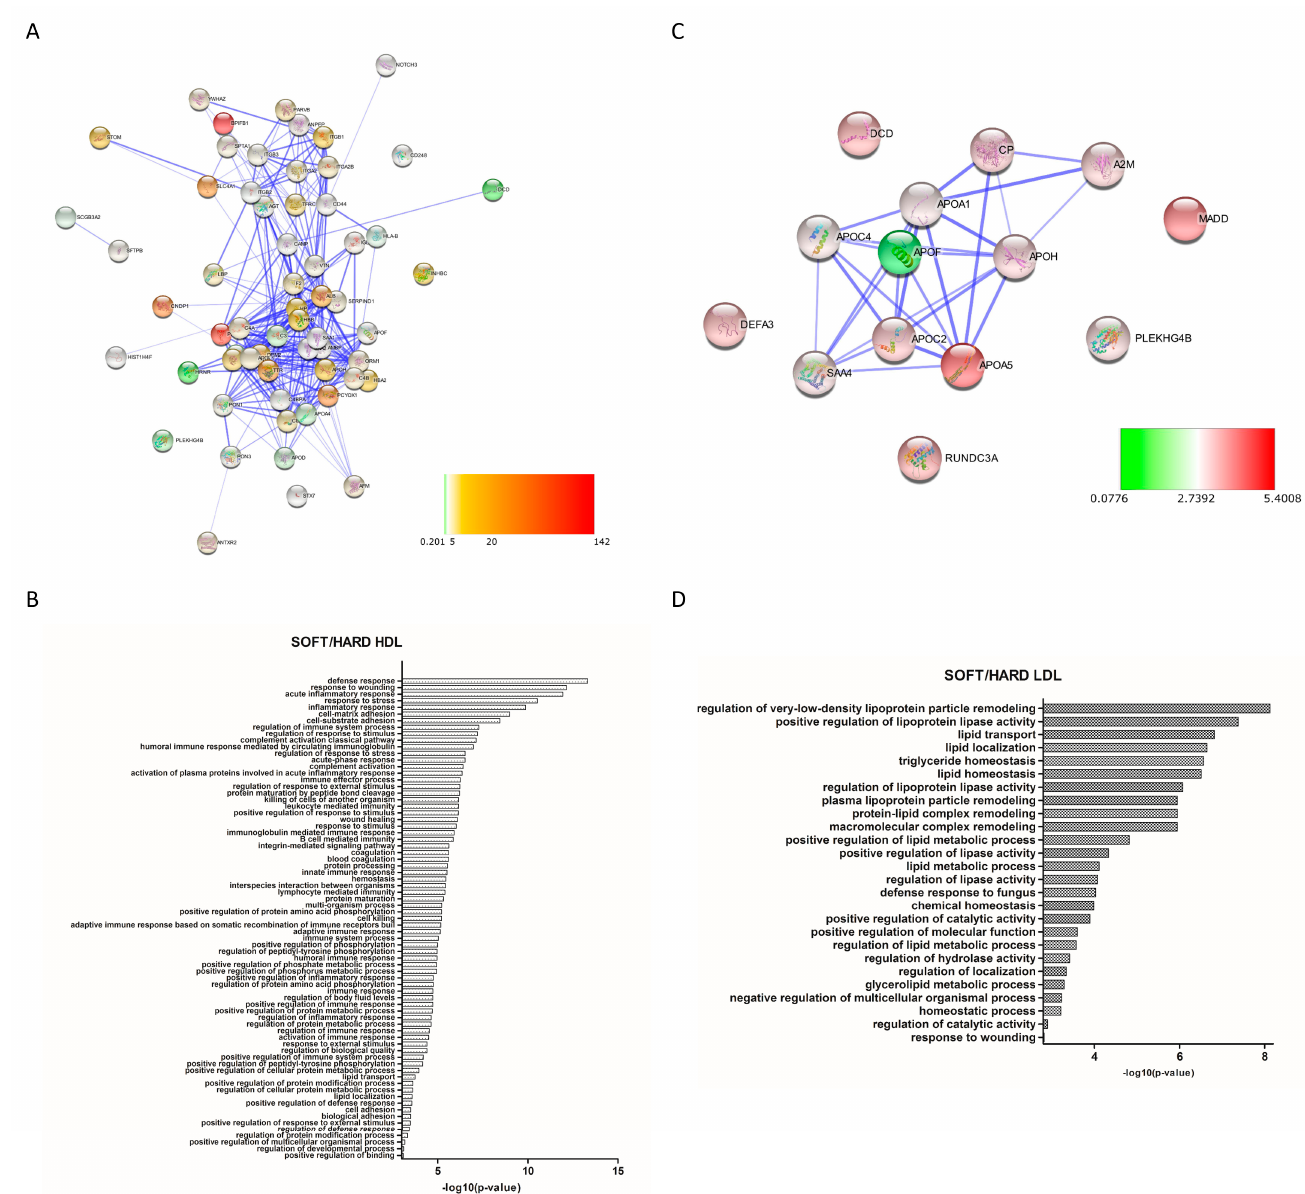
Figure 6. Protein–protein interaction (PPI) network and Gene Ontology (GO) analysis of differentially expressed proteins between HDL “soft” and “hard” plaques ( A , B , respectively) and LDL “soft” and “hard” plaques ( C , D , respectively), showing the biological processes in which these proteins are involved. Colors of nodes in PPI networks are representative of FCs in “soft” compared to “hard” plaques.